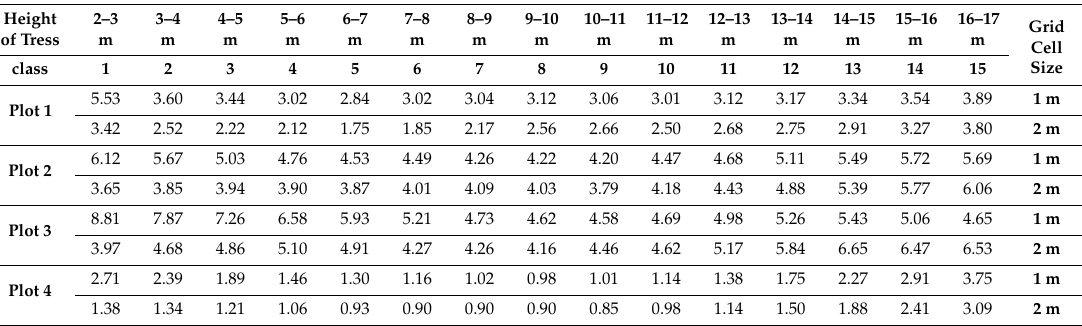
Table 2. The forest cover height structure developed on the basis of light detection and ranging (LiDAR) data for a ff orested areas determined on the basis of a ff orestation acquired using historical stereometric photographs. The forest cover height structure was derived from LiDAR data that corresponded to forest areas in 1966. The table contains the percentage of classes for plots developed for a grid cell size of 1 m and 2